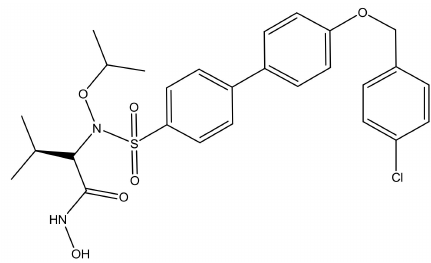
Figure 9. MMP-13 inhibitor synthesized by Nuti et al.